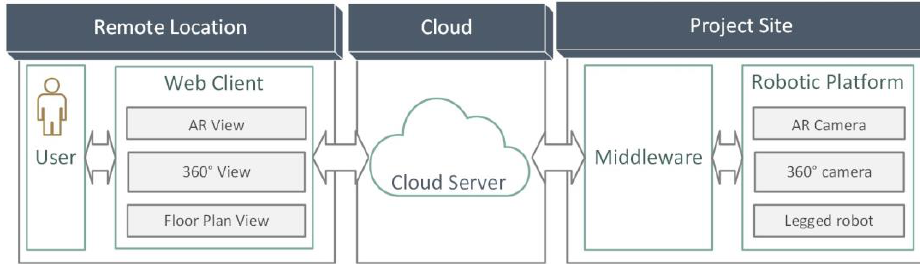
Figure 2. Computational framework for a remote and real-time construction progress monitoring system using AR and Quadruped Robot.